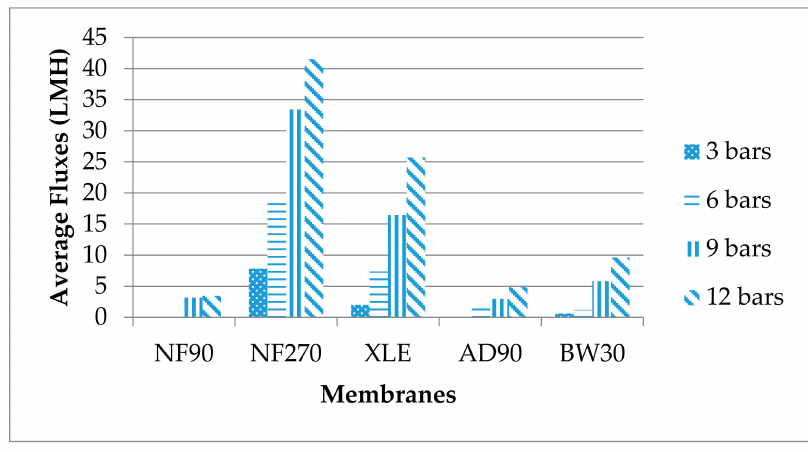
Figure 5. Average flux values of different NF-RO membranes at different